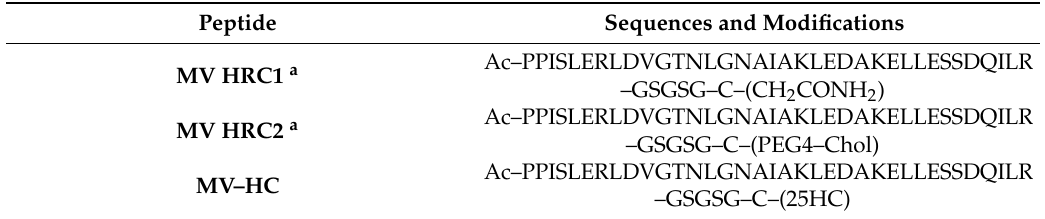
Table 2. Fusion inhibition activity, at 24 h, of MV HRC derived peptides.